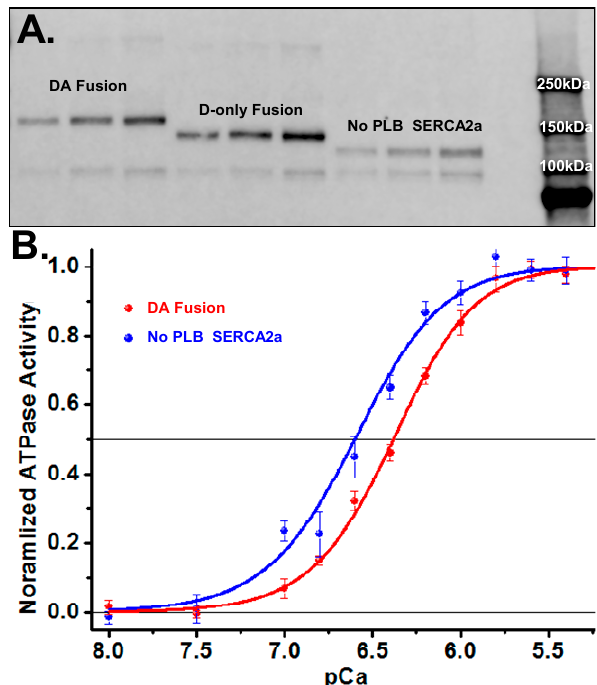
Figure 3. SERCA2a-PLB fusion FRET biosensor expression and activity ( A ) Western blot showing DA (GFP-SERCA2a-RFP-PLB) fusion biosensor (160 kDa) and D-only (GFP-SERCA2a, no PLB) fusion construct (137 kDa). ( B ) Ca 2+ -ATPase activity assays showing decreased apparent Ca 2+ affinity for the SERCA2a-PLB fusion biosensor (blue, pCa50 = 6.62 ± 0.09) compared to the SERCA2a-only control (red, pCa50 = 6.38 ± 0.08). (SEM, n = 8.).